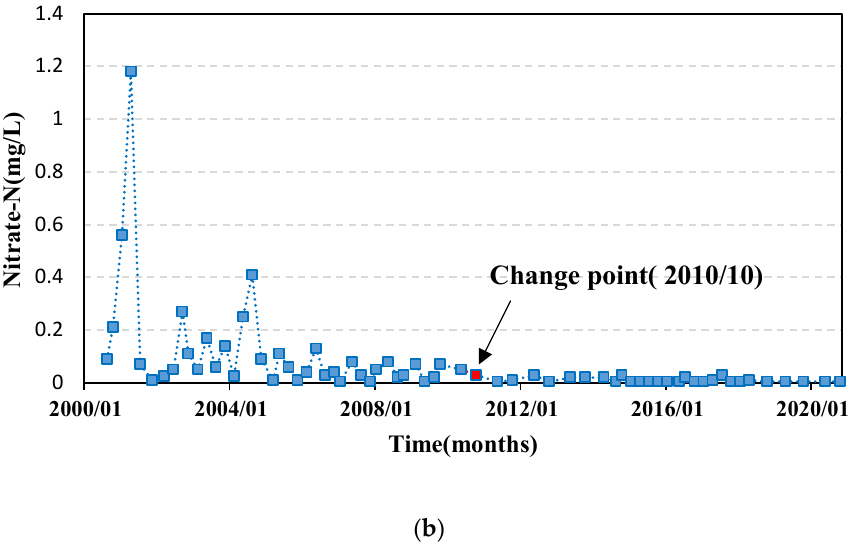
Figure 8. Concentration histograms of ( a ) ammonium–N in monitoring well S17, and ( b ) nitrate–N in monitoring well N18.